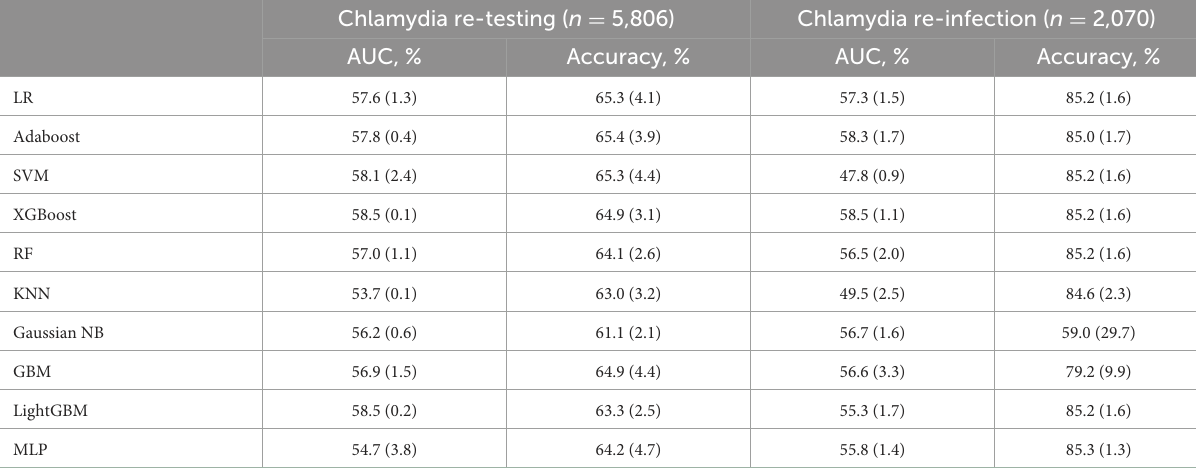
TABLE 3 Machine learning model evaluation of chlamydia re-testing and re-infection within1 year among heterosexual individuals with chlamydia on the testing data set